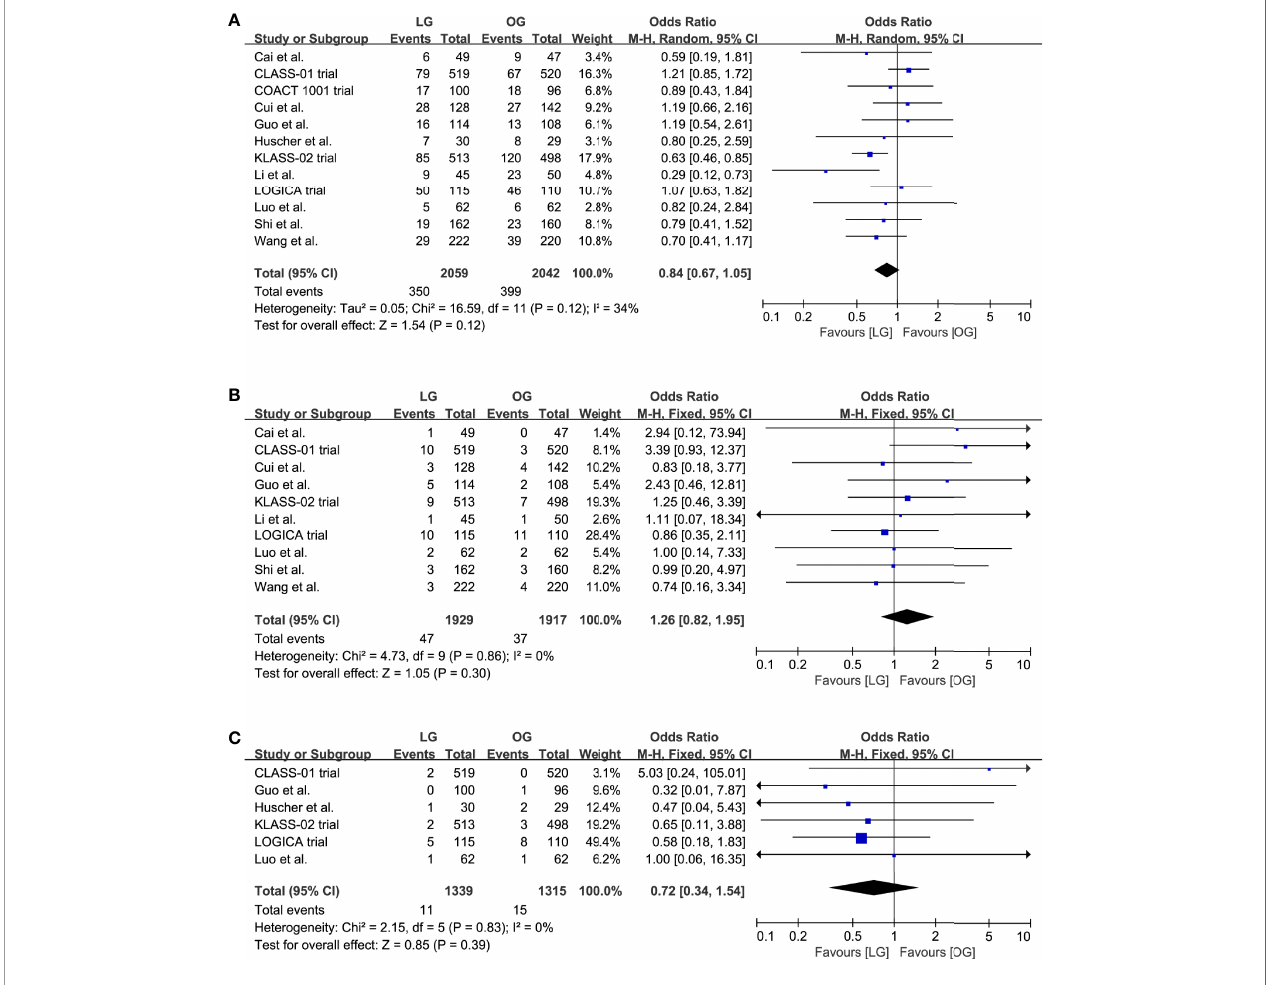
FIGURE 3 | Pooled estimates of (A) overall postoperative complications, (B) incidence of anastomotic leakage, (C) short-term